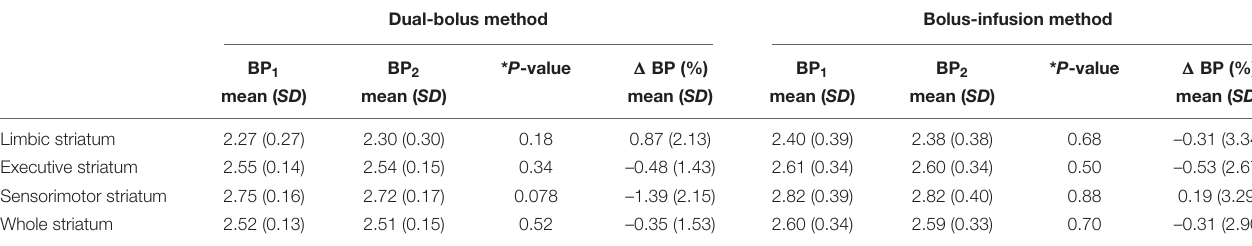
TABLE 2 | Changes in binding potential for PET studies with cognitive task